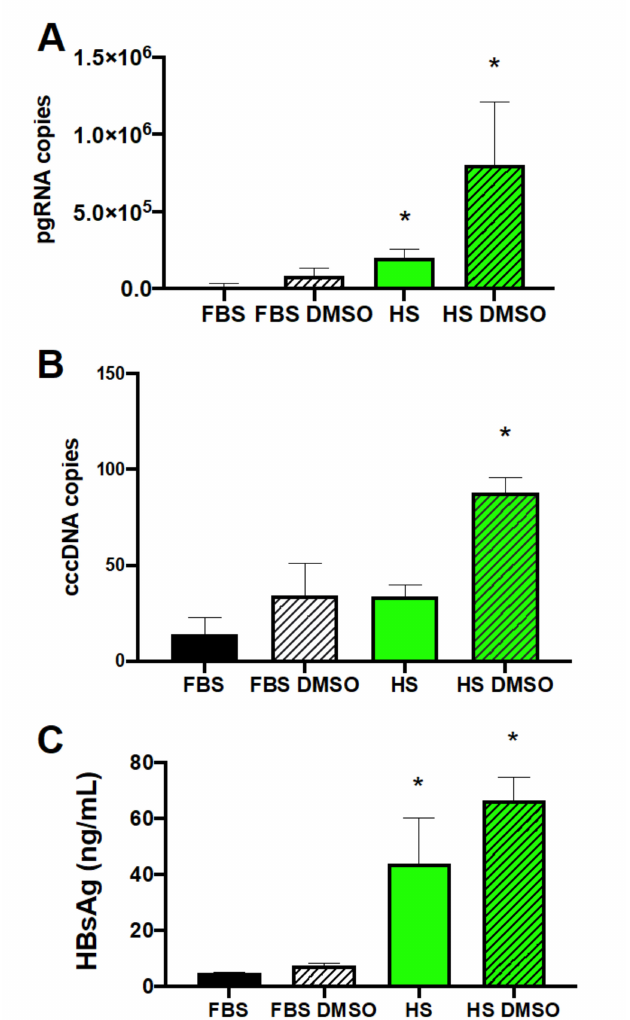
Figure 2. Enhancement of HBV replication by human serum culture. Human serum culture increased HBV ( A ) pgRNA, ( B ) cccDNA, and ( C ) HBV surface antigen (HBsAg) levels from Huh7.5-NTCP cells. Huh7.5-NTCP cells were cultured in the media supplemented with FBS or HS and with or without the addition of DMSO during HBV infection. Samples were collected on day 14 ( A , B ) or day 7 ( C ) post-infection. Pregenomic RNA was measured using RT-qPCR from 10 ng of total RNA. Covalently closed circular DNA was quantified using q-PCR from 10 ng of gDNA. HBsAg was measured in a culture supernatant using enzyme-linked immunosorbent assay (ELISA). Average values with error bars ( ± SD) derived from three experiments are plotted. One-way analysis of variance (ANOVA) was used with the Bonferroni correction for multiple comparison test. * p <